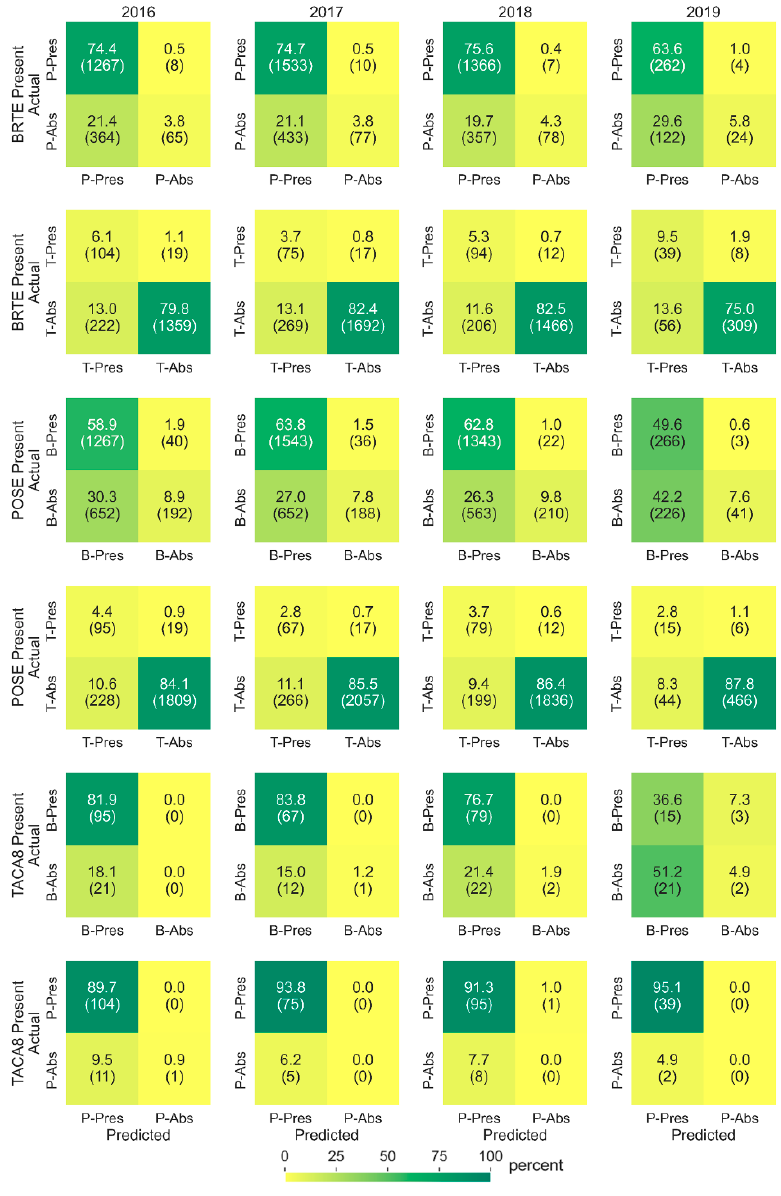
Figure 7. Heat maps showing intra-species annual accuracy matrices for the training plots with one species presence to another species presence or absence for the years 2016–2019. P-Pres is POSE present, P-Abs is POSE absent, T-Pres is TACA8 present, T-Abs is TACA8 absent, B-Pres is BRTE present, and B-Abs is BRTE absent. BRTE is cheatgrass, TACA8 is medusahead, and POSE is Sandberg bluegrass. The values in boxes show the percent accurate, and values inside parentheses represent the number of observations.